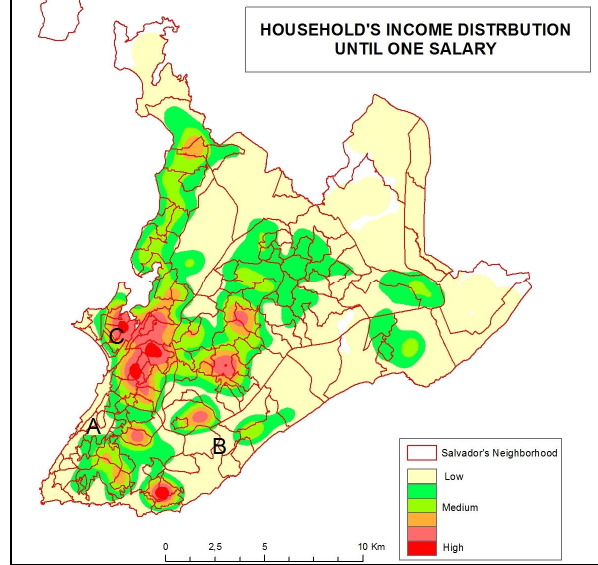
Figure 3: Map of areas with greater concentration of households with income equal or below the minimum wage. Note: kernel density estimation based on percentage of households with this low income within the census